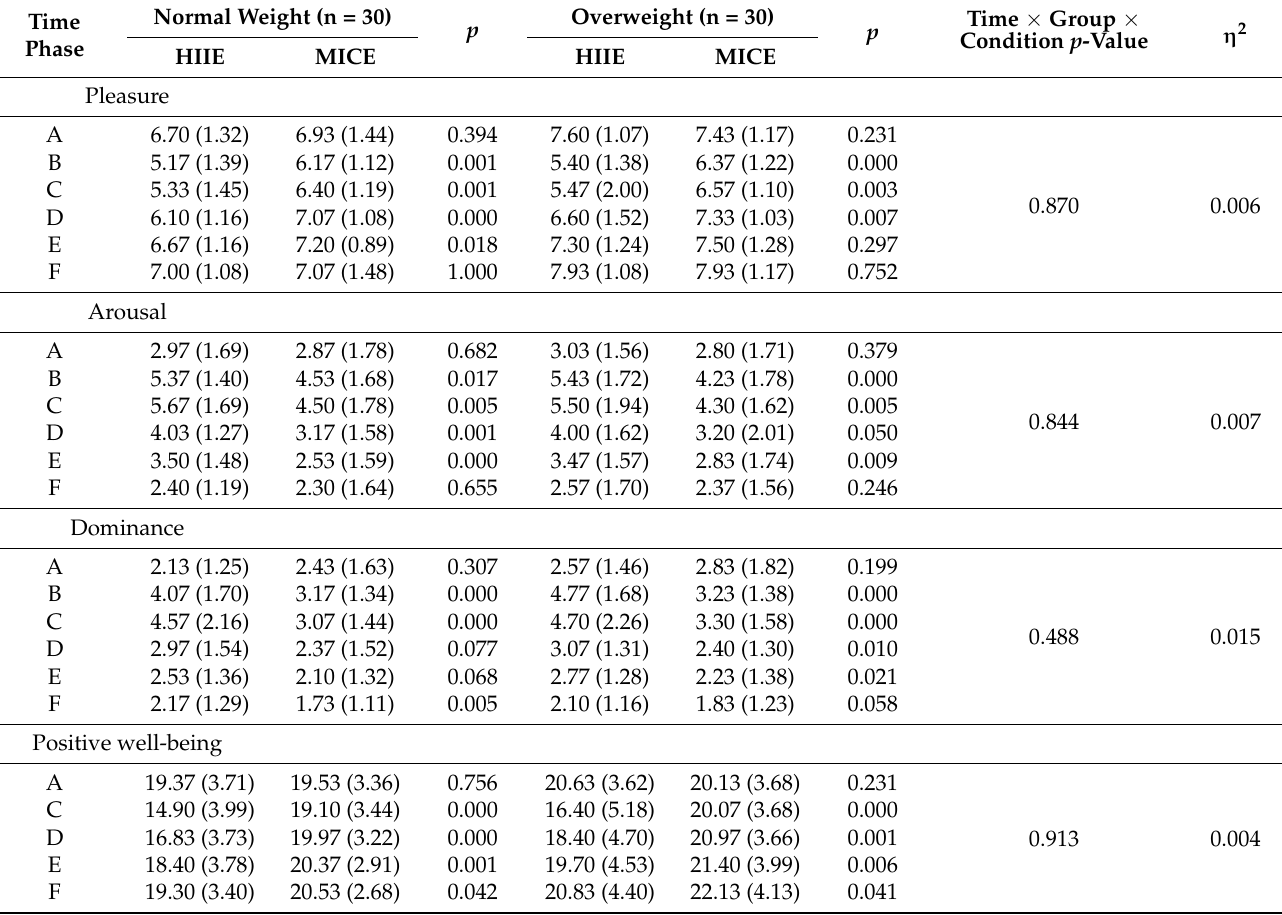
Table 2. “Pleasure, Arousal, Dominance, Positive well-being, Psychological distress and Fatigue” changes between the two groups during HIIE and MICE